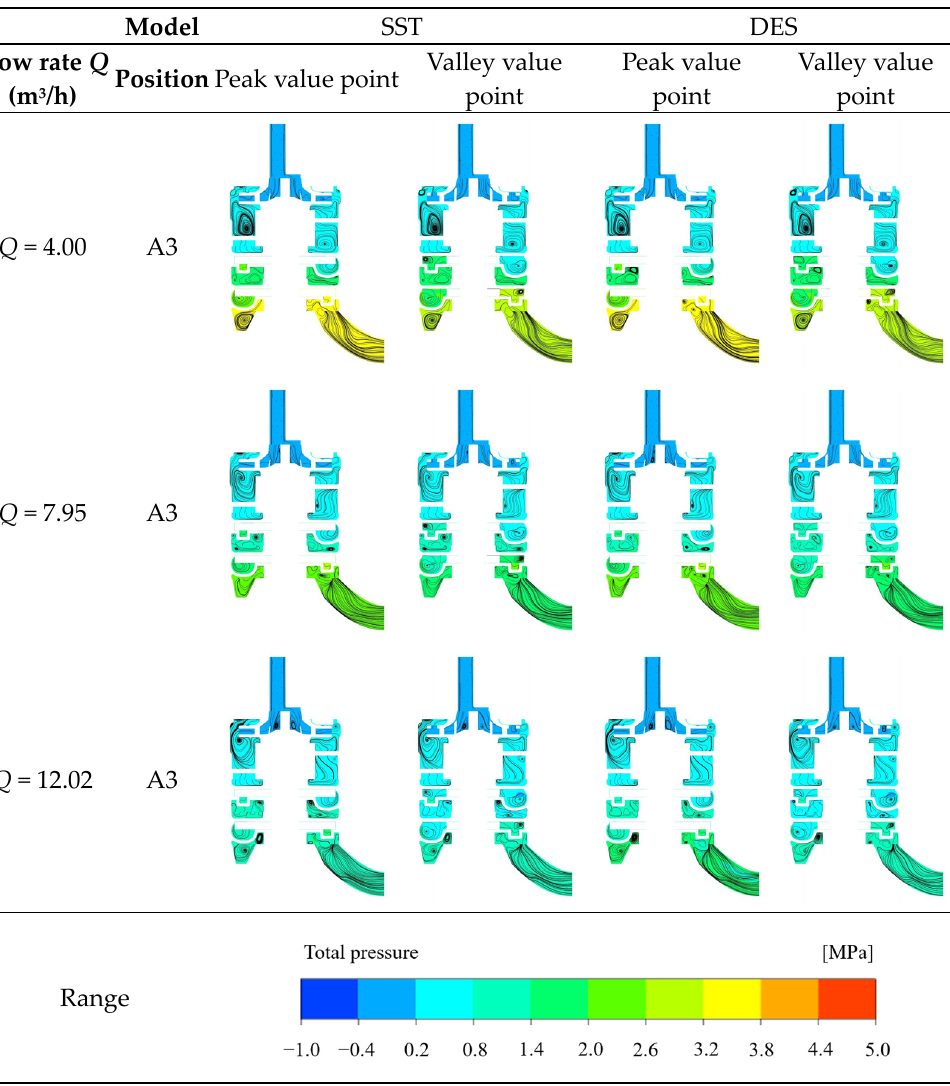
Figure 9. Meridional plane streamlines pressure distribution of the SST and DES models at the peak and valley points of the head.